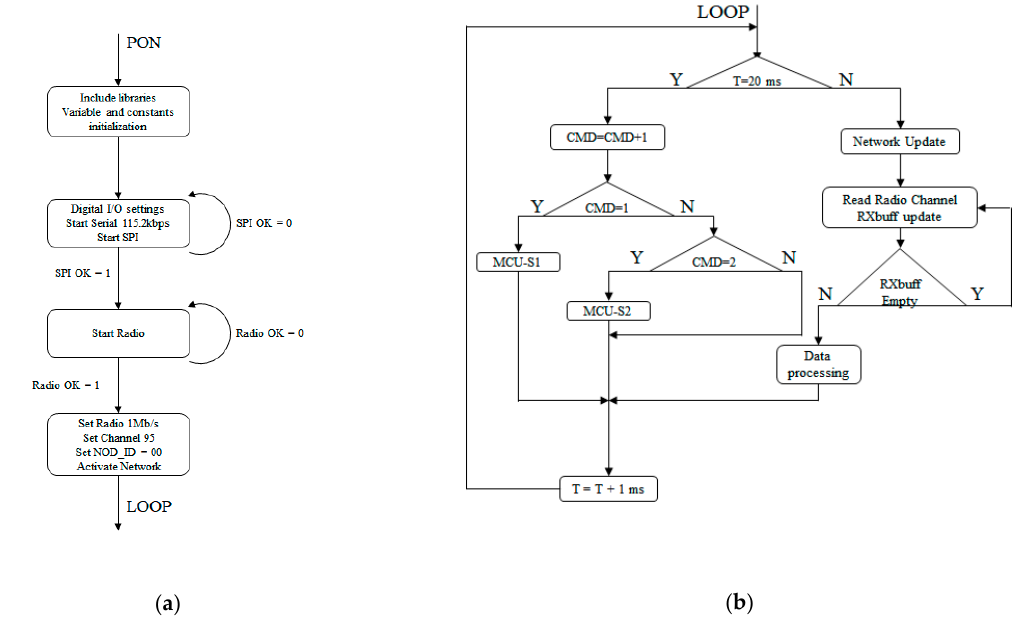
Figure 11. SETUP state ( a ) and LOOP state ( b ) diagrams for the MCU software.